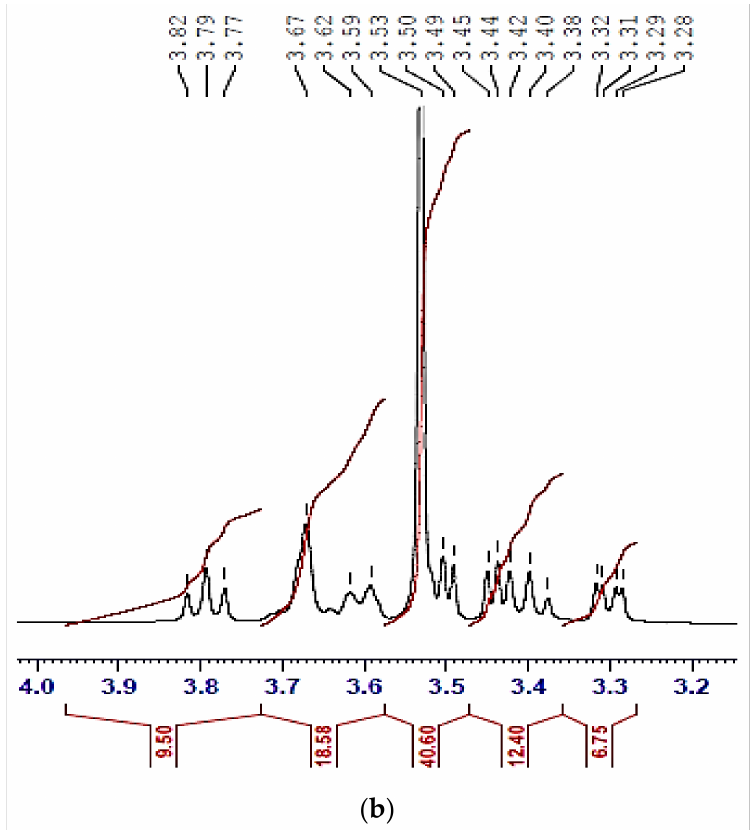
Figure 5. ( a ) 1 H-NMR spectra for PEG/ α -CD in DMSO-d6, and ( b ) expanded section of aliphatic protons in α -CD. Table 6. Chemical shifts (ppm) for the protons of pure α -cyclodextrin and inclusion polymer complex PEG/ α -CD (1).